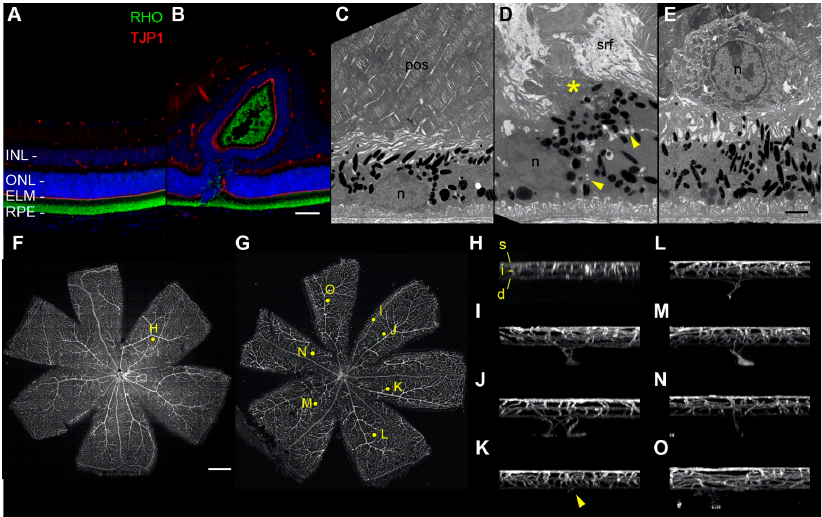
Figure 6. Fluorescence and electron microscopy analysis of control and tvrm77 mice at 1 month of age. ( A , B ) Fluorescence microscopy of ( A ) B6 (n = 4) and ( B ) tvrm77 (n = 5) mice with antibodies against rhodopsin (RHO) and ELM protein TJP1. Scale bar in B , 50 µm, applies to ( A , B ). ( C – E ) TEM of B6 (n = 4) and tvrm77 (n = 5) posterior eyecups. Representative TEM of B6 samples ( C ) reveals normal apposition of photoreceptor outer segments (pos) with RPE cells. Nuclei, n. In tvrm77 eyecups ( D , E ), subretinal fluid (srf) and debris (asterisk) accumulate above a region of RPE perturbation. A cell boundary (yellow arrowheads) can be seen separating the primary RPE layer from a displaced RPE cell or cellular process. In ( E ), a nucleated cell, likely an immune cell, lies at the retina–RPE interface. Scale bar in I, 2 µm, applies to ( C , D ) . ( F , G ) Maximum intensity projections of retinal flatmounts (n = 6) of B6 ( F ) or tvrm77 ( G ) mice stained with isolectin B4. Yellow dots indicate regions selected for orthogonal display in panels ( H – O ). Scale bar in ( F ), 0.5 mm, applies to ( G ). ( H ) Orthogonal maximum intensity projection of a 0.3 mm square region of interest in panel ( F ). Normal superficial (s), intermediate (i), and deep (d) vascular beds appear in B6 retinas. ( I – O ) Projections of all detected neovascular lesions from the tvrm77 retina in G are shown. The vessels appear to originate from the deep vascular bed and migrate toward the outer retina. In ( K ), the neovascular structure (arrowhead) is smaller compared to the others observed and may represent an early stage of lesion formation.